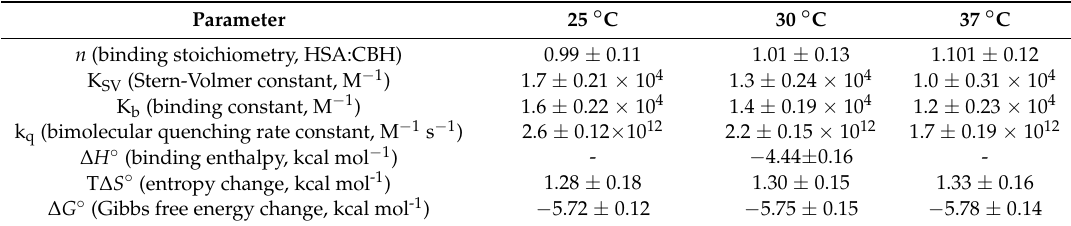
Figure 5. ( A ) Stern-Volmer plot, and ( B ) a double-logarithm plot for the quenching of HSA by CBH at three different temperatures (°C). Table 1. The quenching constant (K sv ), binding constant (K b ), binding stoichiometry ( n ), and thermodynamic parameters between HSA and CBH from fluorescence quenching experiments at 25, 30 and 37 ◦